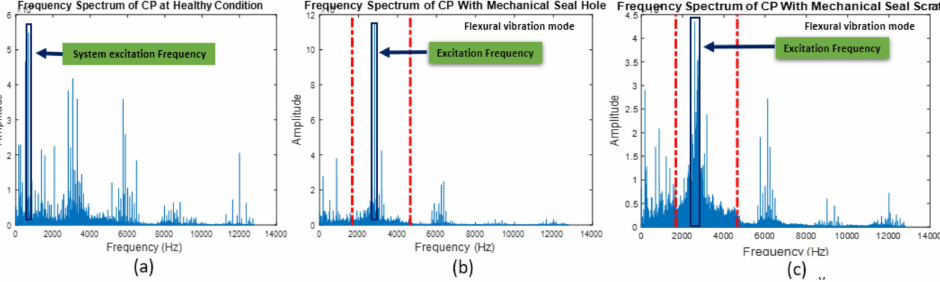
Figure 9. Frequency spectrum of the CP. ( a ) Healthy conditions, ( b ) MSH fault, and ( c ) MSS